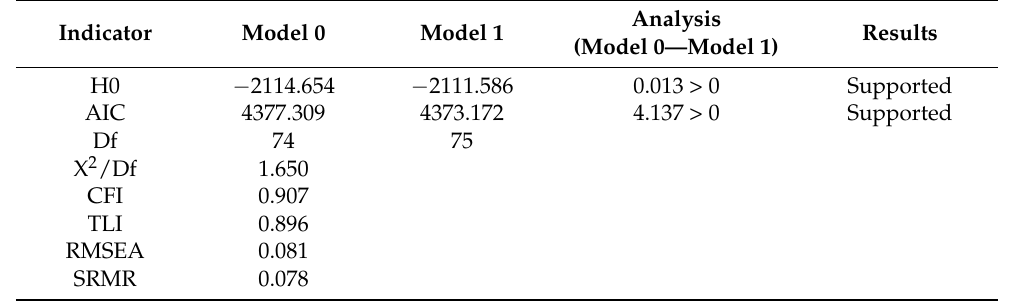
Table 4. Moderated mediation model.